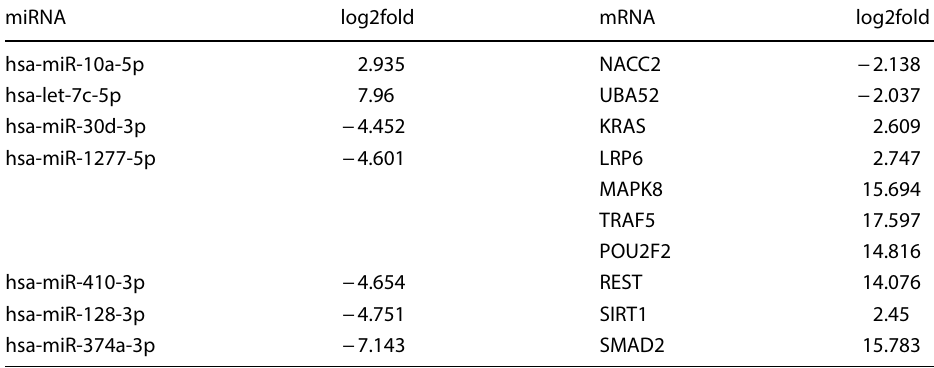
Table 10 List of correlated miRNA and mRNA transcripts observed in OS-EP compared to